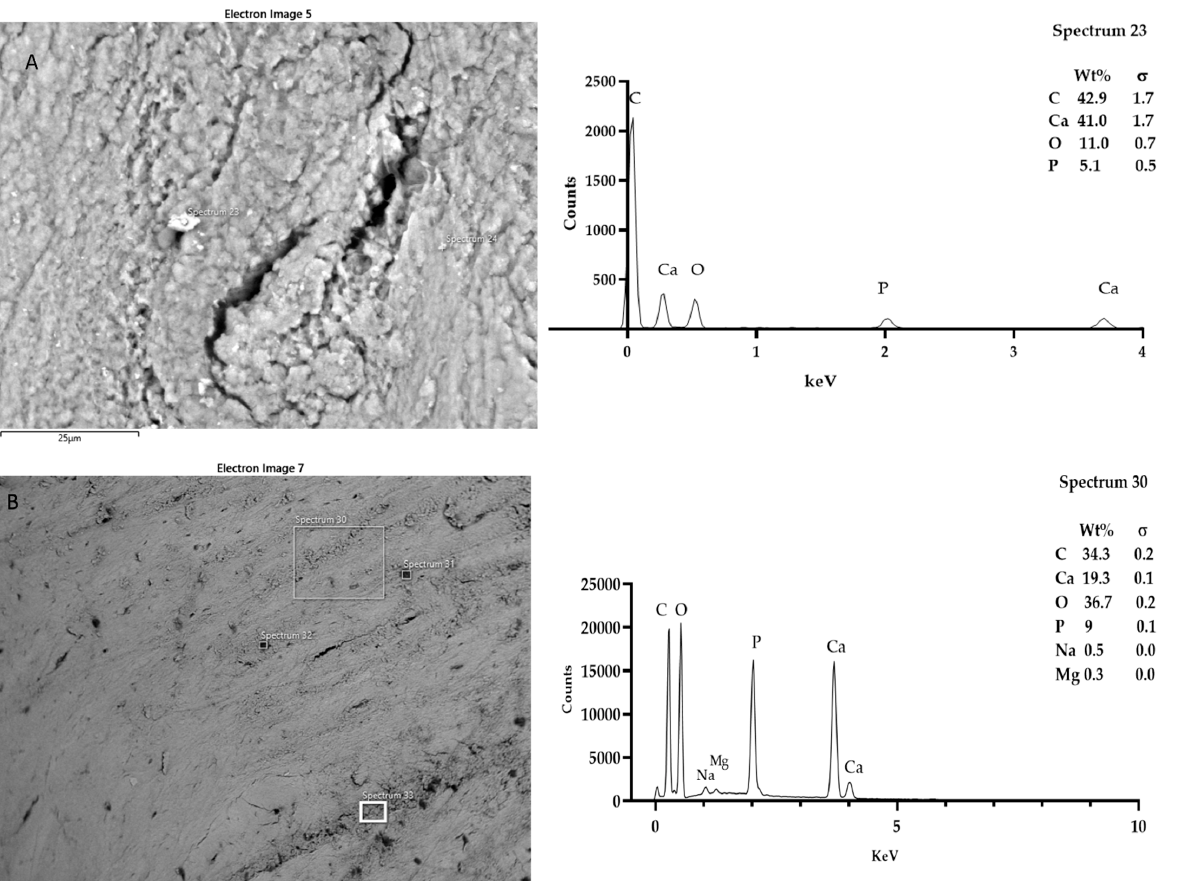
Figure 6. SEM-EDX analysis of samples T1 ( A ) and T2 ( B ). Looking at the morphology of the bone tissue of the samples T1 and T2, it was possible to notice some somewhat luminescent particles. However, the particles analyzed in T1 and T2 had the typical composition of bone tissue: calcium phosphate and carbon. Spectra outputs were realized using GrapPad Prism